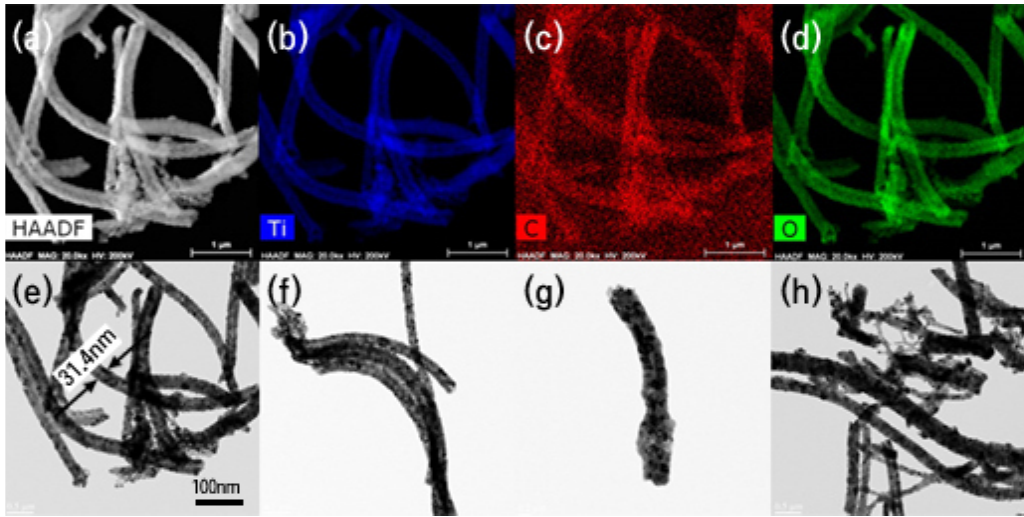
Figure 5. Typical HRTEM images of the S4 (800) ( a , e ) and elemental mapping patterns of titanium ( b , f ), carbon ( c , g ) and oxygen ( d , h ).